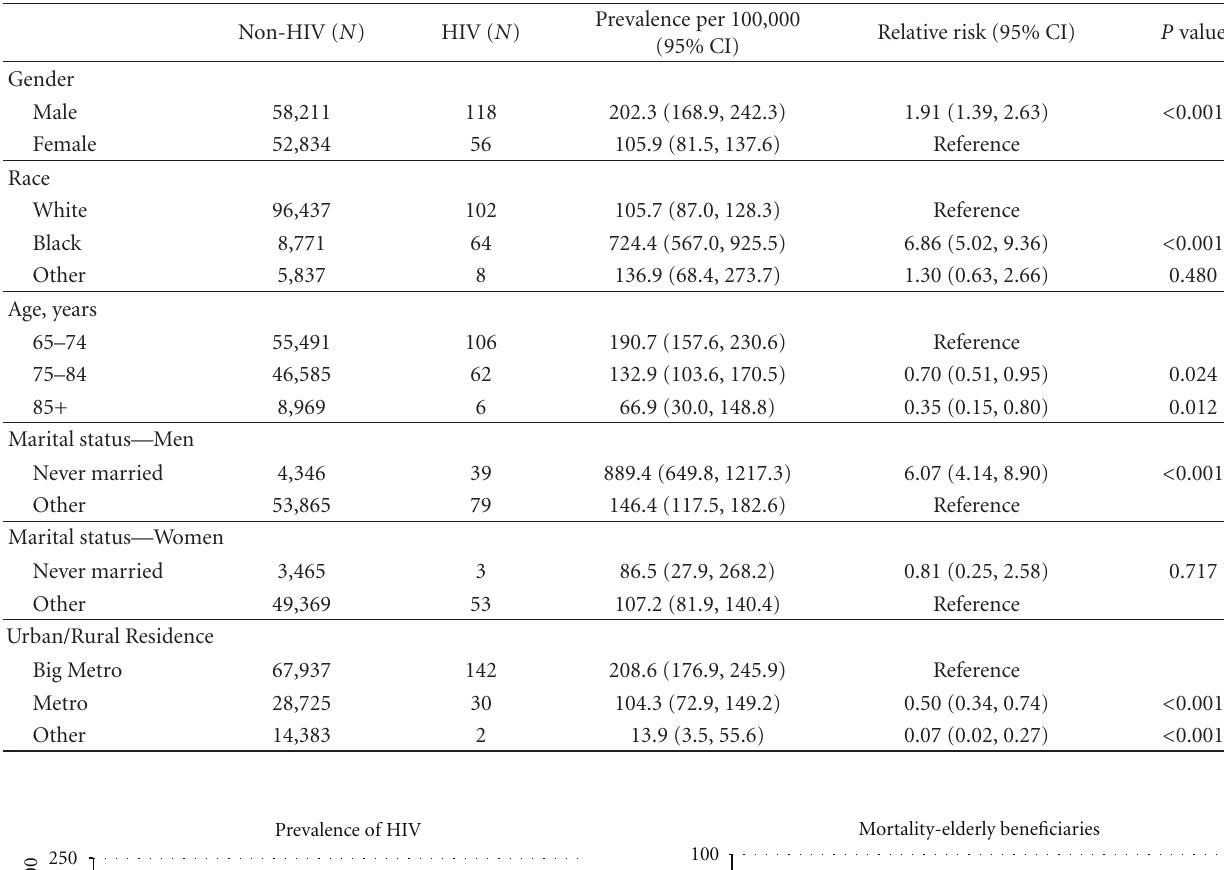
Table 2: Prevalence of HIV among Medicare Beneficiaries 65 years of age and older who qualified based on age.